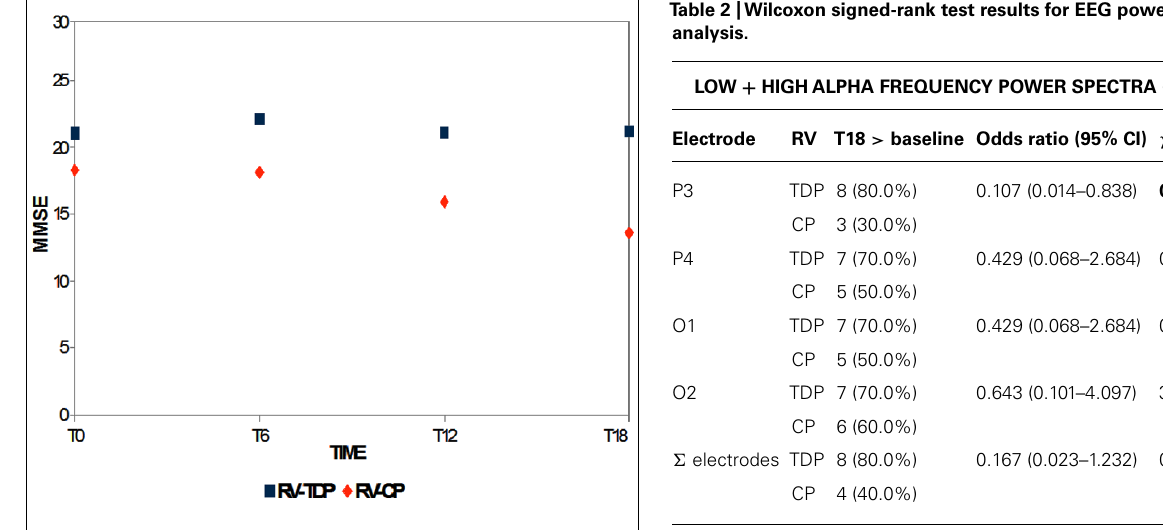
Table 2 |Wilcoxon signed-rank test results for EEG power spectra analysis.